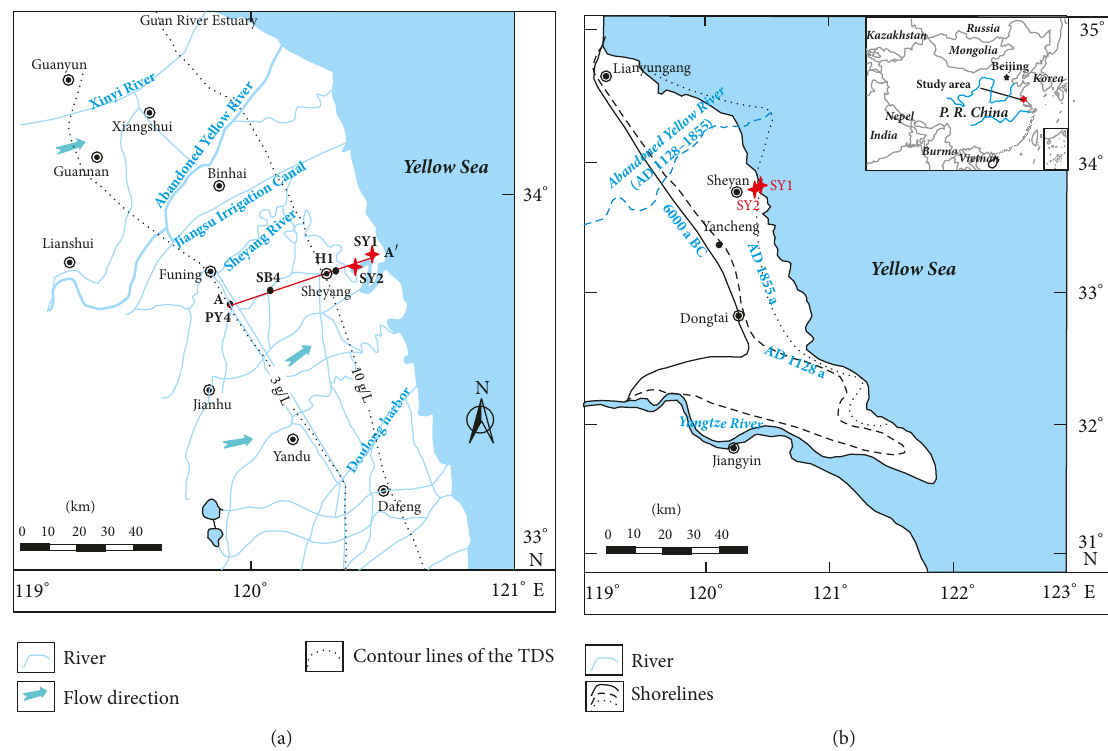
Figure 1: (a) Location map of the research area and (b) various shorelines of different time in the study area (modified after Liu et al. [22]).